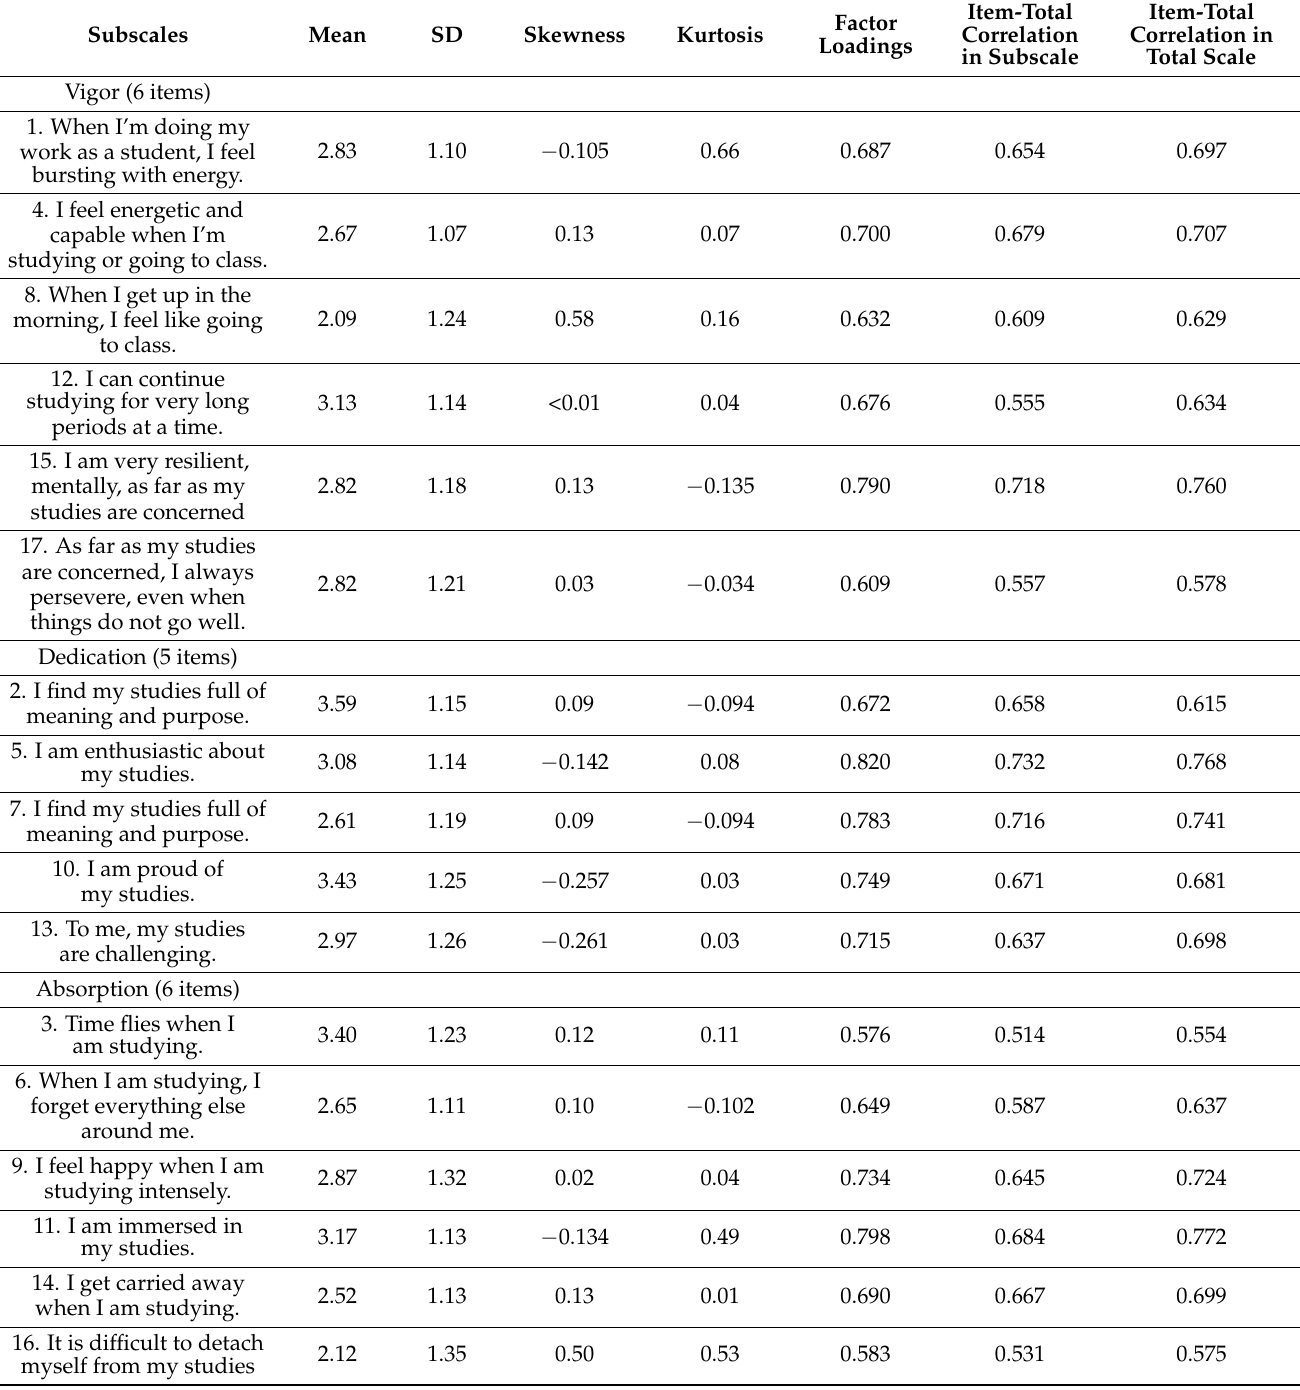
Table 1. Item descriptive analysis and internal consistency reliability of the KUWES-S ( N =